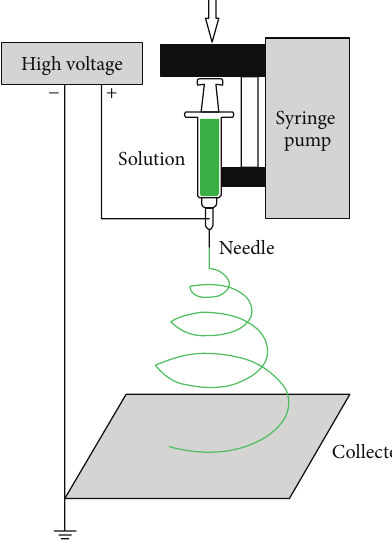
Figure 2: Schematic diagram of an electrospinning